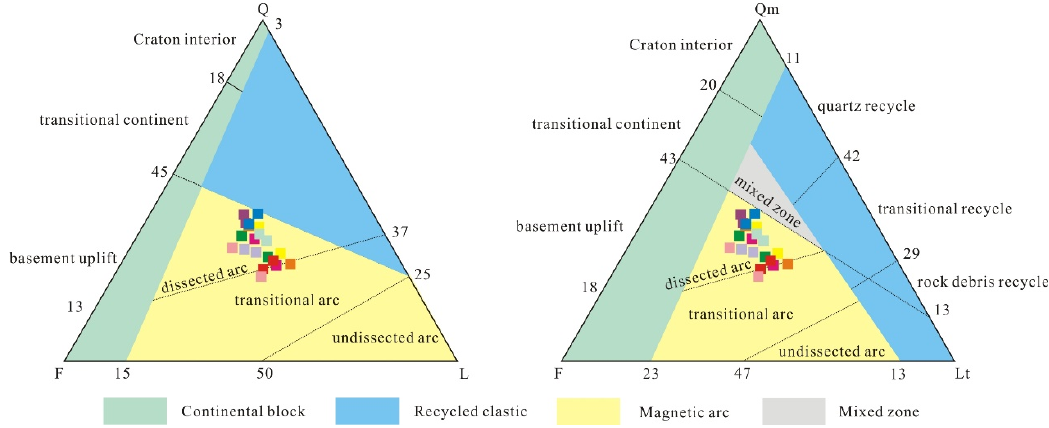
Figure 16. Analysis of tectonic background based on Q-F-L and Qm-F-Lt [55]. The specific process of tectonic evolution is proposed as follows (Figure 17): a. During the Early and Middle Jurassic, the Yarlung-Zangbo Tethys Ocean subducted northward, and the Bangong-Nujiang Tethys Ocean subducted southward. Along with continuous subduction, arc basin systems (fore-arc basins, island arcs, and back-arc basins) were formed on the margins of the central and northern Lhasa Block. The mid-oceanic ridge of the Namtso-Shiquan River Ocean spread and developed between the Middle Lhasa Block and the North Lhasa Block [14,62]. b. From the Middle Jurassic to the Early Cretaceous, the Yarlung-Zangbo Tethys Ocean and the Bangong-Nujiang Tethys Ocean floors continued to be subducted in their original direction. However, the Namtso-Shiquan River small oceanic basin began to subduct southward, forming an arc-basin systems on the northern margin of the Central Lhasa Block. The subduction polarity of the Bangong-Nujiang Oceanic Basin changed, from southward to northward subduction gradually, and the oceanic basin also began to decrease. The subducting polarity of the Namtso-Shiquan River small oceanic basin also changed, from southward subduction to northward subduction, forming an arc-basin system on the southern margin of the North Lhasa Block. c. By the Late Cretaceous, the Yarlung-Zangbo Tethys Ocean continued to be subducted northward, the area of the Namtso small oceanic basin decreased, and the residual oceanic basin continued to subduct northward. At this time, the subducting polarity of the remnant Bangong-Nujiang Oceanic Basin changed again and became a southward subduction. Finally, only the Yarlung-Zangbo Tethys Ocean was still subducting northward, and the plates of the Bangong-Nujiang Oceanic Basin and the Namtso small oceanic basin were fragmented and stopped subducting. The Bangong-Nujiang Tethys Ocean and the Namtso-Shiquan River Ocean became completely closed, forming the Bangong-Nujiang Suture zone and the Shiquan River-Namtso-Bomi Suture zone, respectively. In this way, the integration between the North Lhasa Block and the Central Lhasa Block, and that between the Lhasa Block and the South Qiangtang Block was fully realized. As a foreland basin, Nyima Basin was formed under the combined action of the southward subduction by the Bangong-Nujiang Oceanic Basin and the northward subduction by the Namtso-Shiquan River small oceanic basin, and developed a thrust structure. As a result, the Nyima Basin was formed under the combined action of the southward subduction by the Bangong-Nujiang Oceanic Basin and the northward subduction by the Shiquan River-Namtso small oceanic basin. This was actually the “soft collision” of the arc-basin system by the North Lhasa Block and the South Qiangtang Block. As a foreland basin, thrust structure developed during the orogenic process.